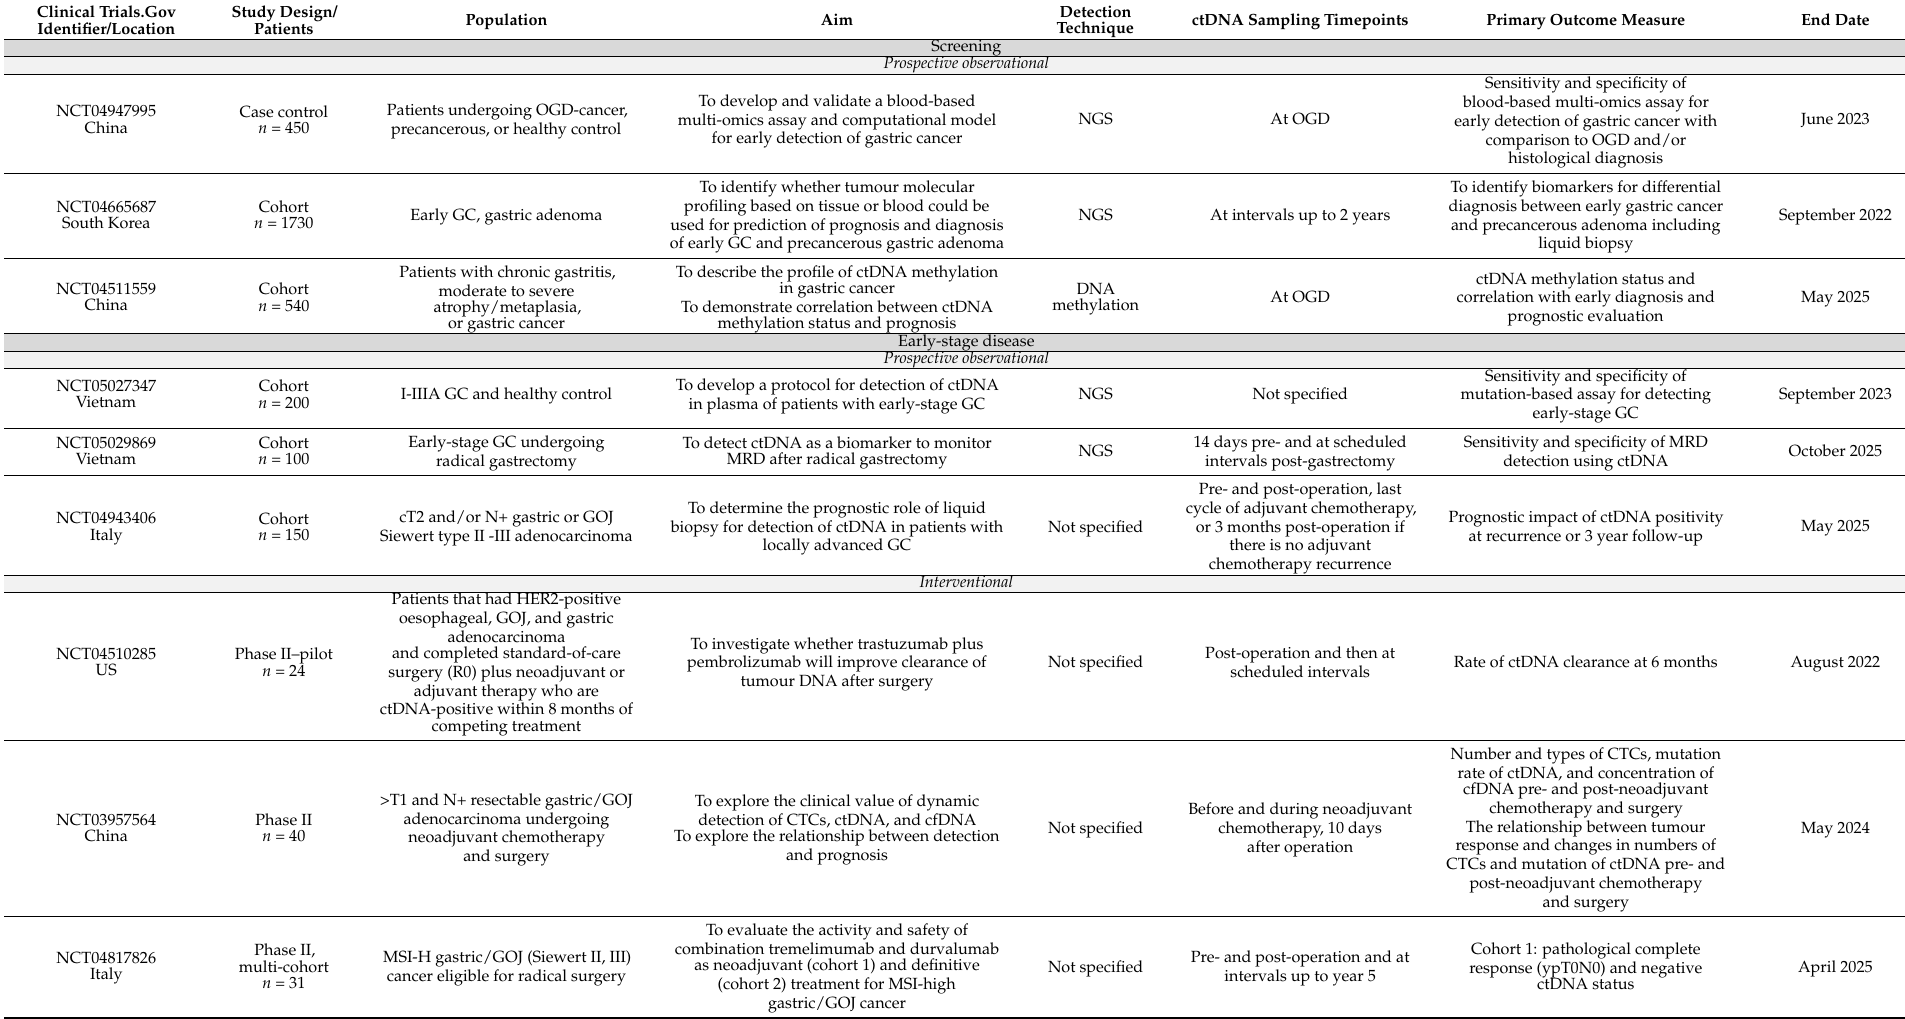
Table 3. Ongoing clinical trials using ctDNA in gastric